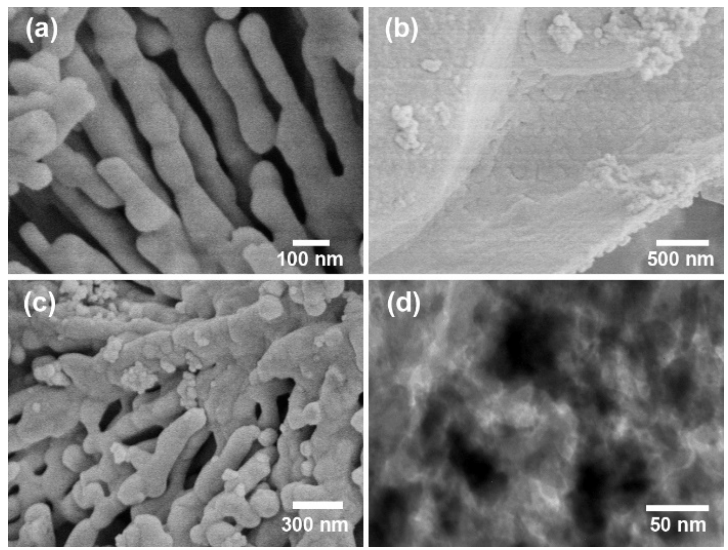
Figure 4. SEM patterns of SSO sample ( a ), CN sample ( b ), 40SSO/CN sample ( c ), and TEM pattern of 40SSO/CN sample ( d ).